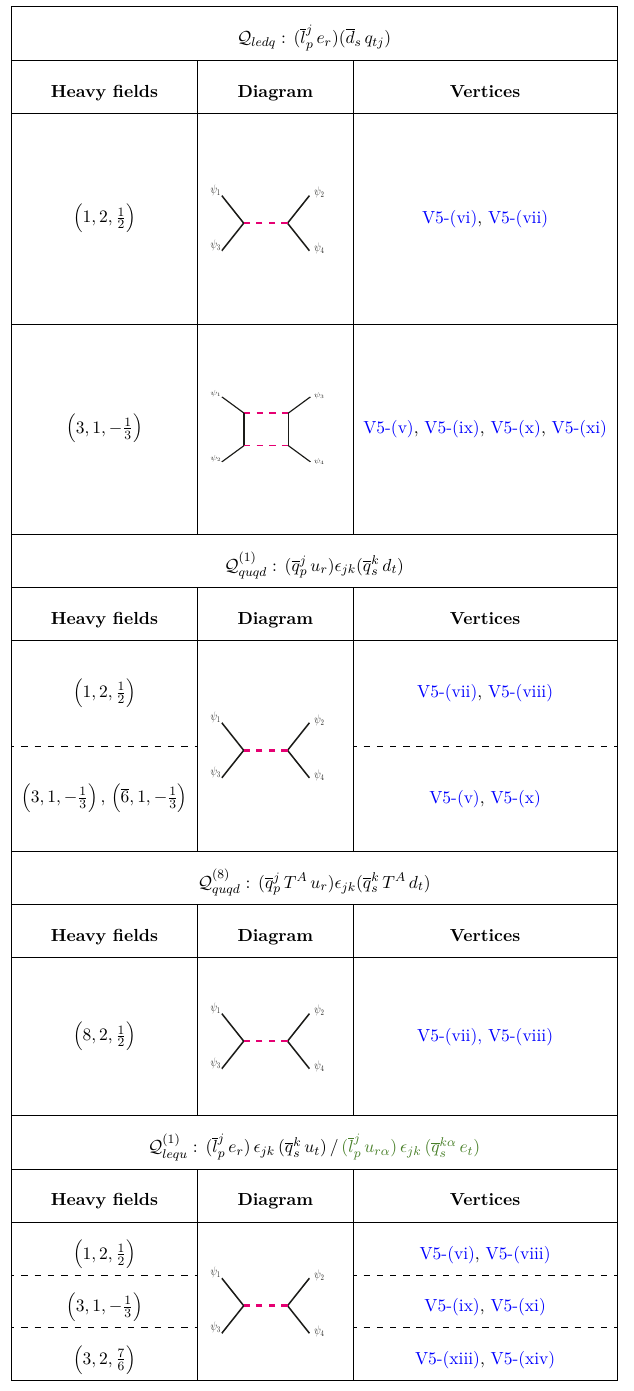
Table 19 . Heavy field representations that are obtained by unfolding the ψ 4 operators, composed of both left and right chiral SM fermions, into non-trivial tree- and (or) one-loop-level diagrams and the corresponding vertices. These operators contain atleast 3 unique fields as their constituents and they do not permit a vector boson propagators when we restrict to minimal scenarios. The operator highlighted in green color is constituted of the same external states as a SMEFT operator but leads to unique heavy field representations, see eq.